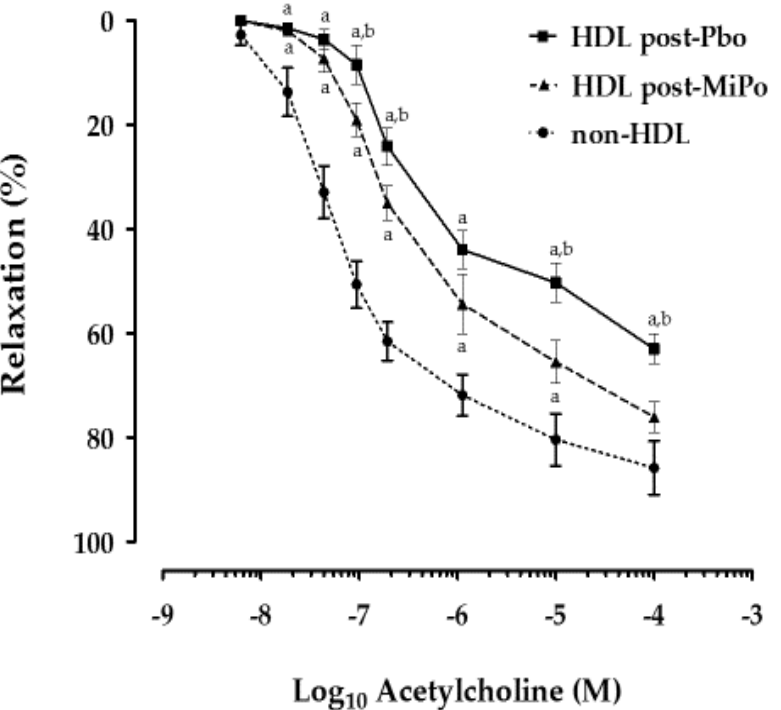
Figure 4. E ff ect of MiPo on endothelial-dependent relaxation of rabbit aortic rings incubated with HDL from rabbits. Curves represent the percentage of relaxation of pre-contracted aorta rings with phenylephrine as a function of the logarithm of increasing acetylcholine concentration. Aorta rings were incubated with HDL from rabbits after 30 days of supplementation with MiPo (post-MiPo, black triangles) and administration with the encapsulating agent of MiPo, maltodextrin (post-Pbo; black squares). Each point represents the mean and standard error of the mean (SEM; n = 6). As reference, a curve of aorta rings without HDL is included (non-HDL, black circles). ANOVA, Least significant di ff erence (LSD) post-hoc test, a p < 0.05 vs. control, b p < 0.05 vs. MiPo after 30 days of supplementation.